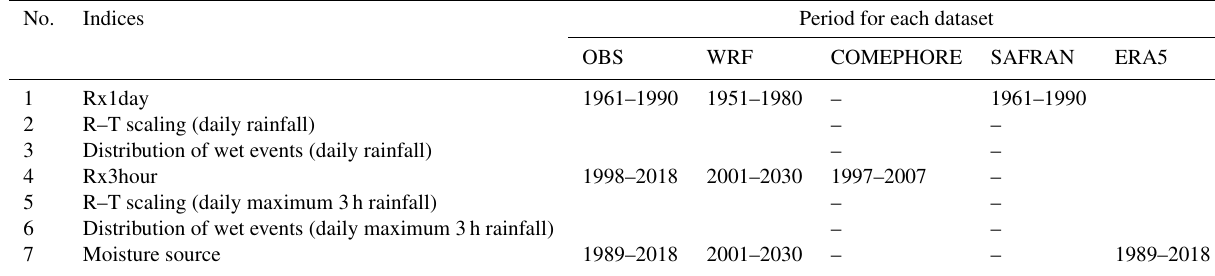
Table 1. The selection of periods of simulations and reference datasets for evaluation of each index.